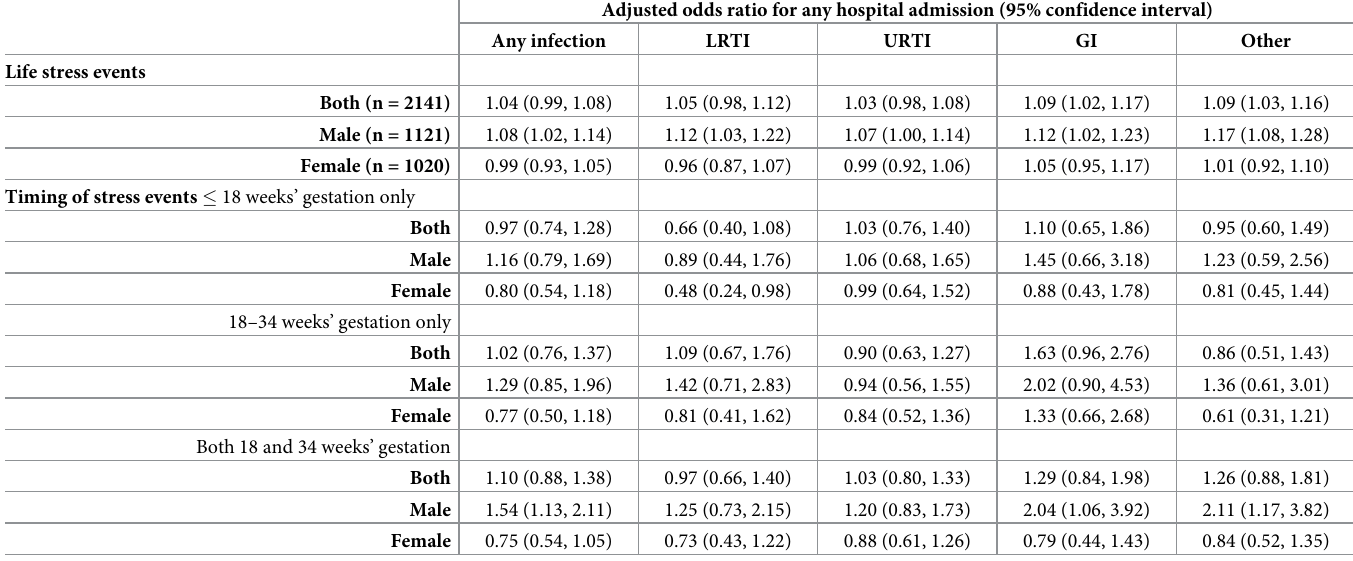
† odds ratio and 95% confidence intervals. Model adjusted for maternal age at pregnancy, maternal education at pregnancy and maternal smoking in pregnancy. LRTI: Lower respiratory tract infection; URTI: Upper respiratory tract infection; GI: Gastrointestinal infection; Other: Genitourinary infection, skin and soft tissue infection or other viral infection.